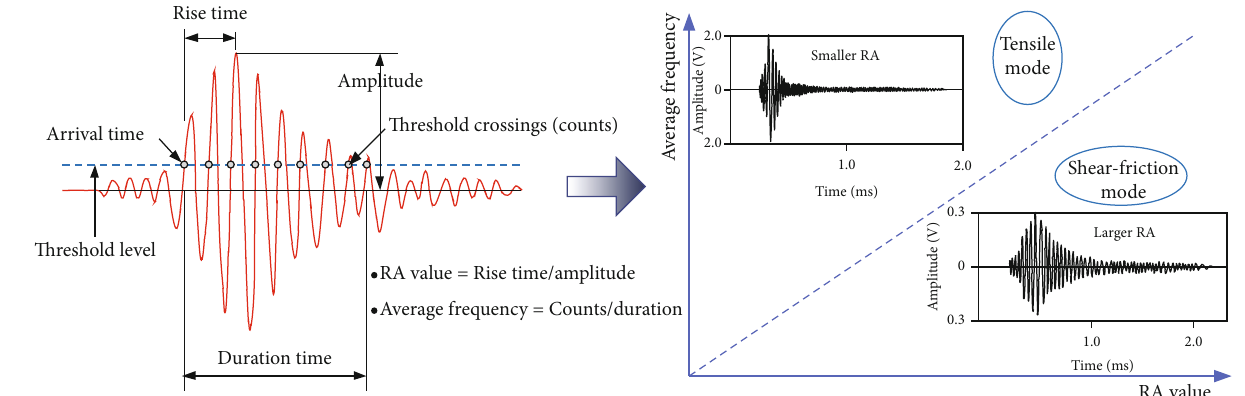
Figure 4: AE signal classi fi cation of tensile crack and shear-friction crack.